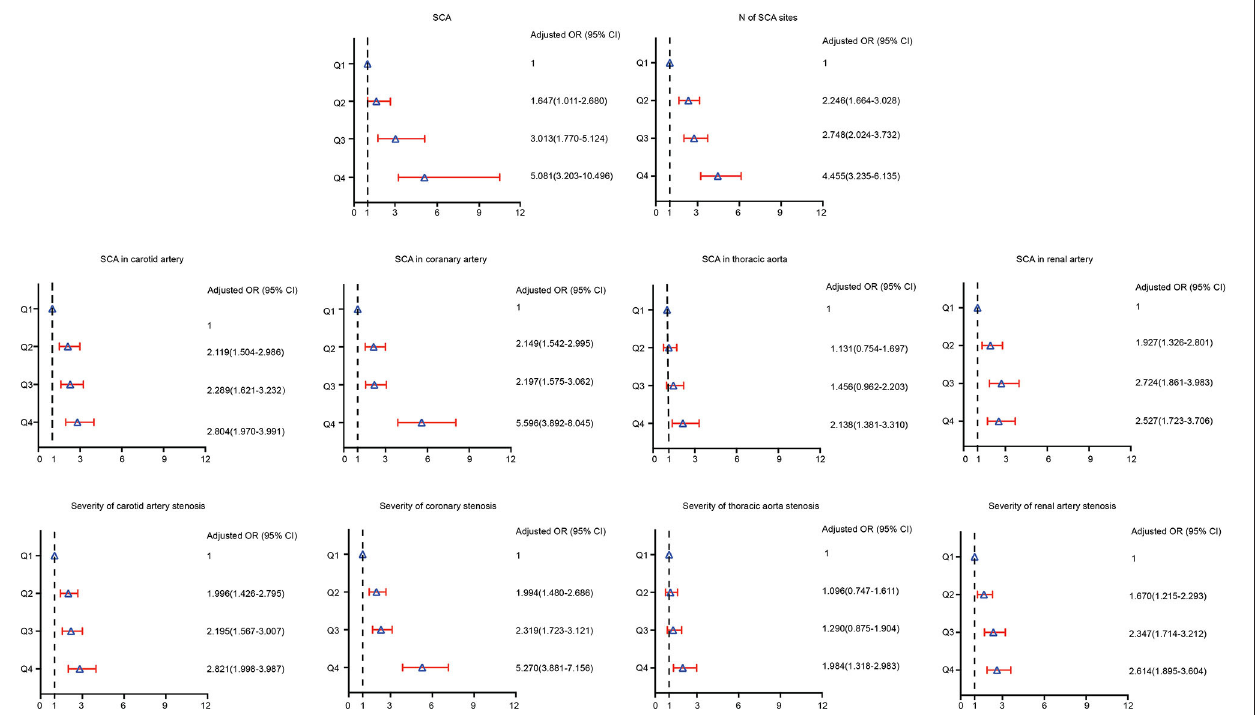
(1.689, 10.754), and 10.889 (3.034, 39.078), respectively. Also, an increase in one standard deviation of SUA (87.85 µ mol/L) was significantly associated with SCA in those patients regardless of the different category of FHS 10-year risk ( Figure 3B ), with the ORs for SCA at low, moderate and high FHS risk groups were 1.873, 1.675, and 2.528,